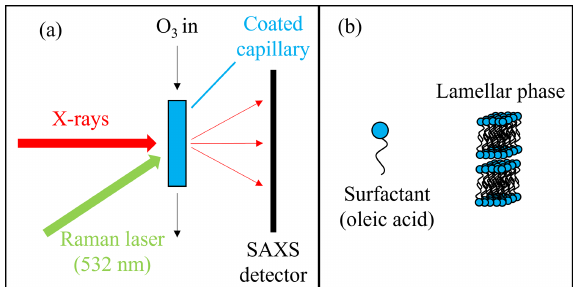
Figure 1. (a) A schematic representation of the small-angle X-ray scattering (SAXS) and Raman spectroscopy experiments. (b) The lamellar phase formed by oleic acid and sodium